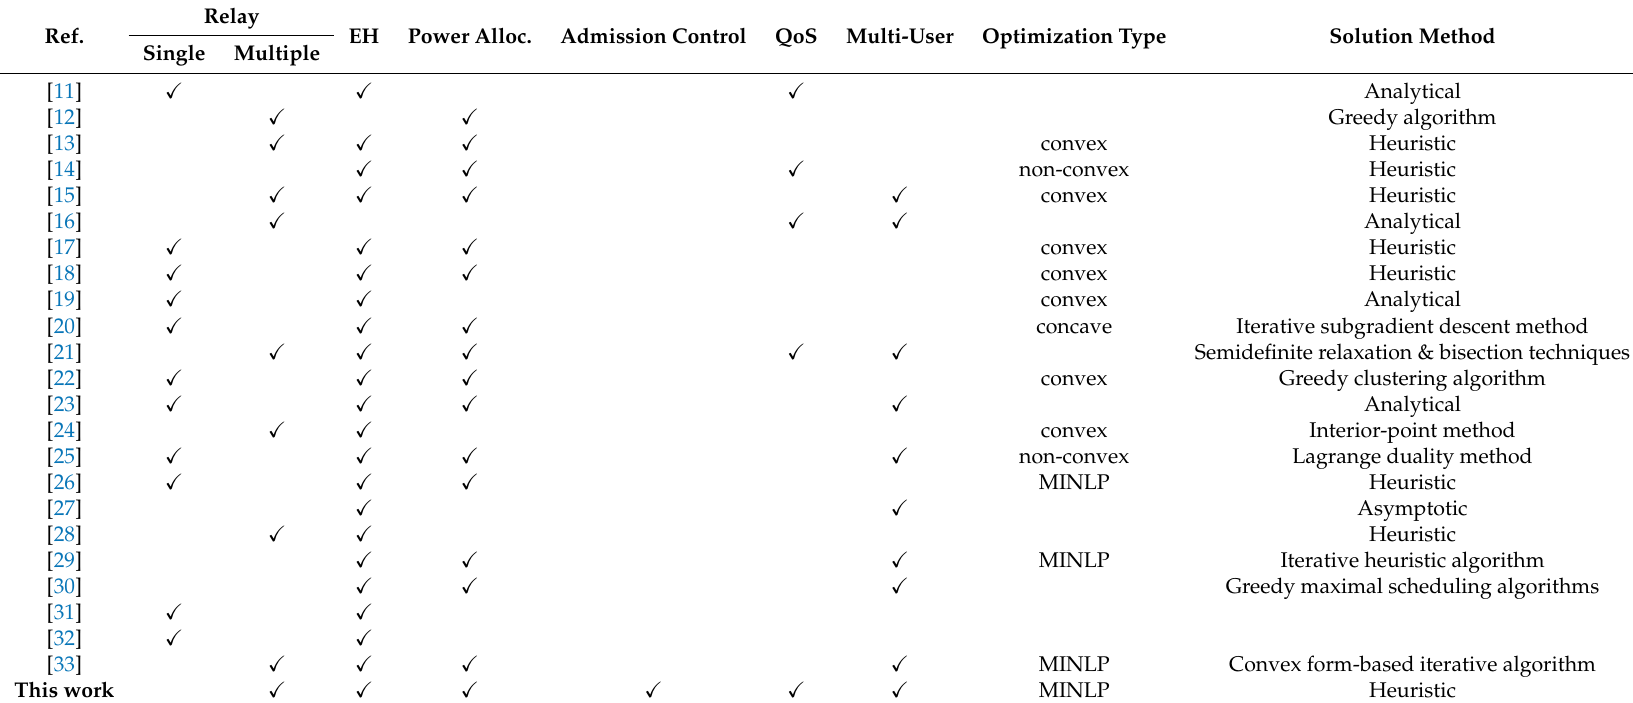
Table 1. Literature review of resource management in EH cooperative